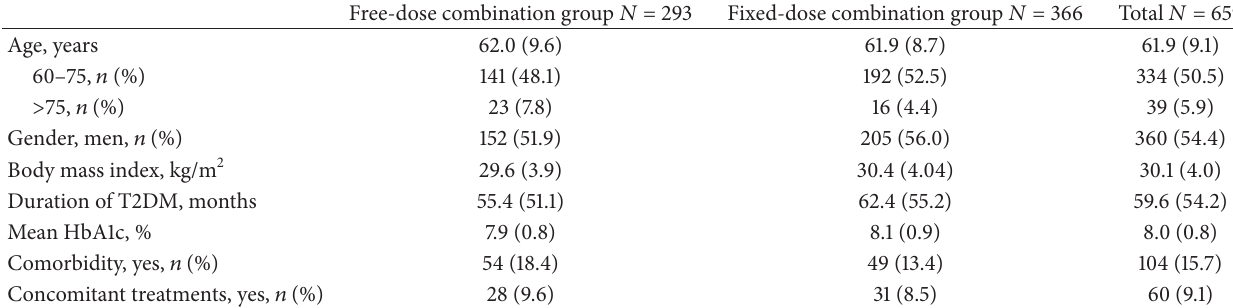
Table 2: Patient baseline and demographic characteristics.